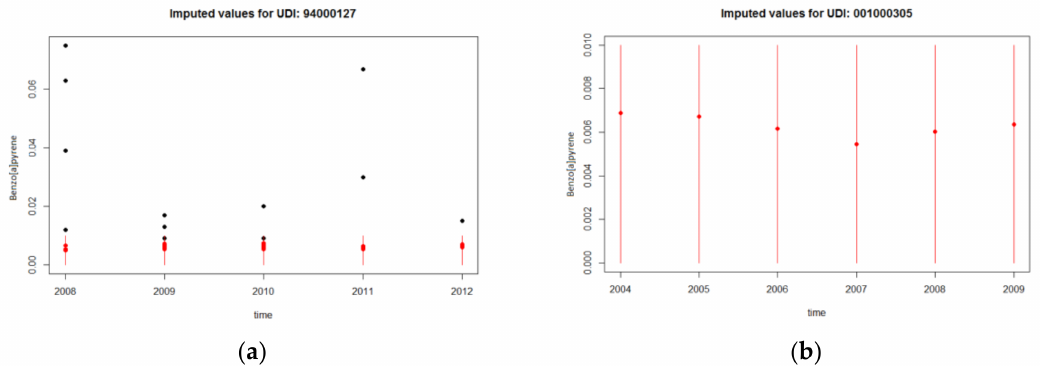
Figure 2. Example of imputations for two water distribution units measured in mg/L; the black points correspond to observed values (>detection limit (DL)), while the red points correspond to the imputation for the same unobserved point, across the datasets obtained from the multiple